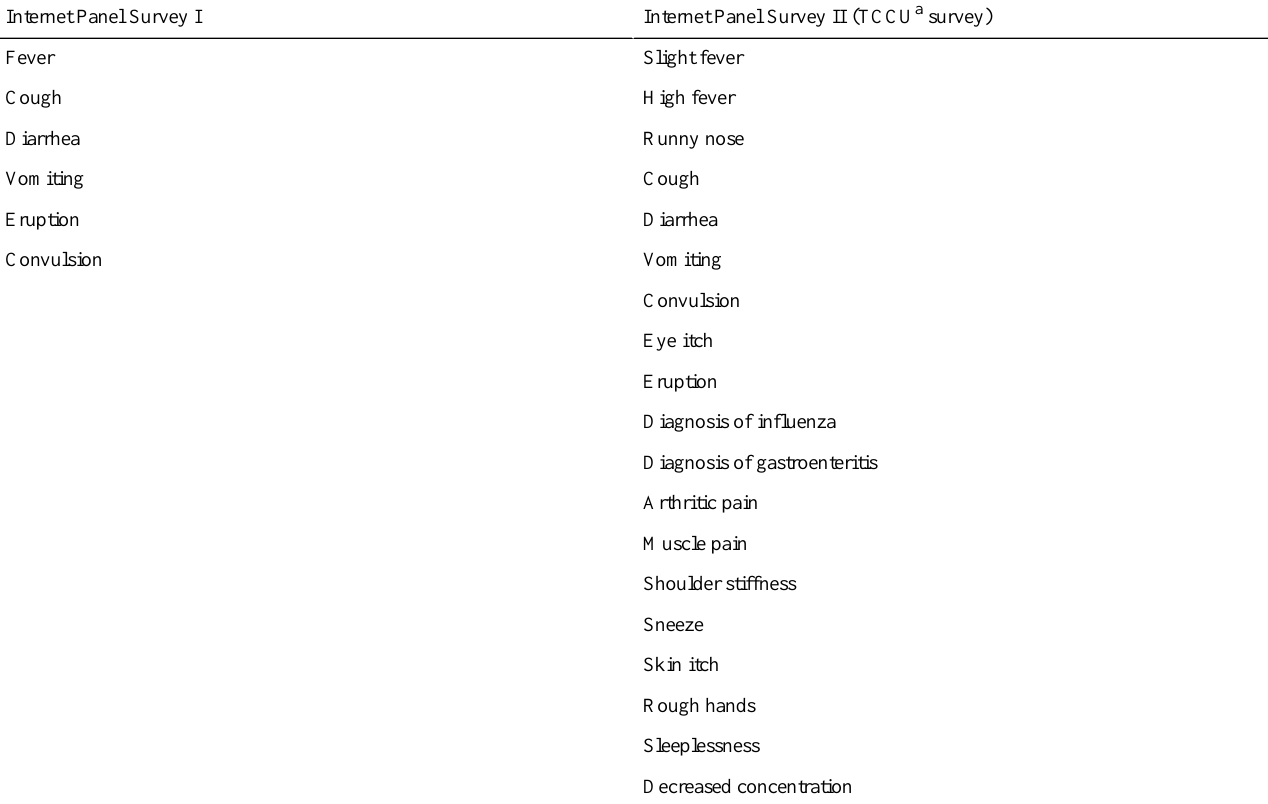
Table 1. Items in the three